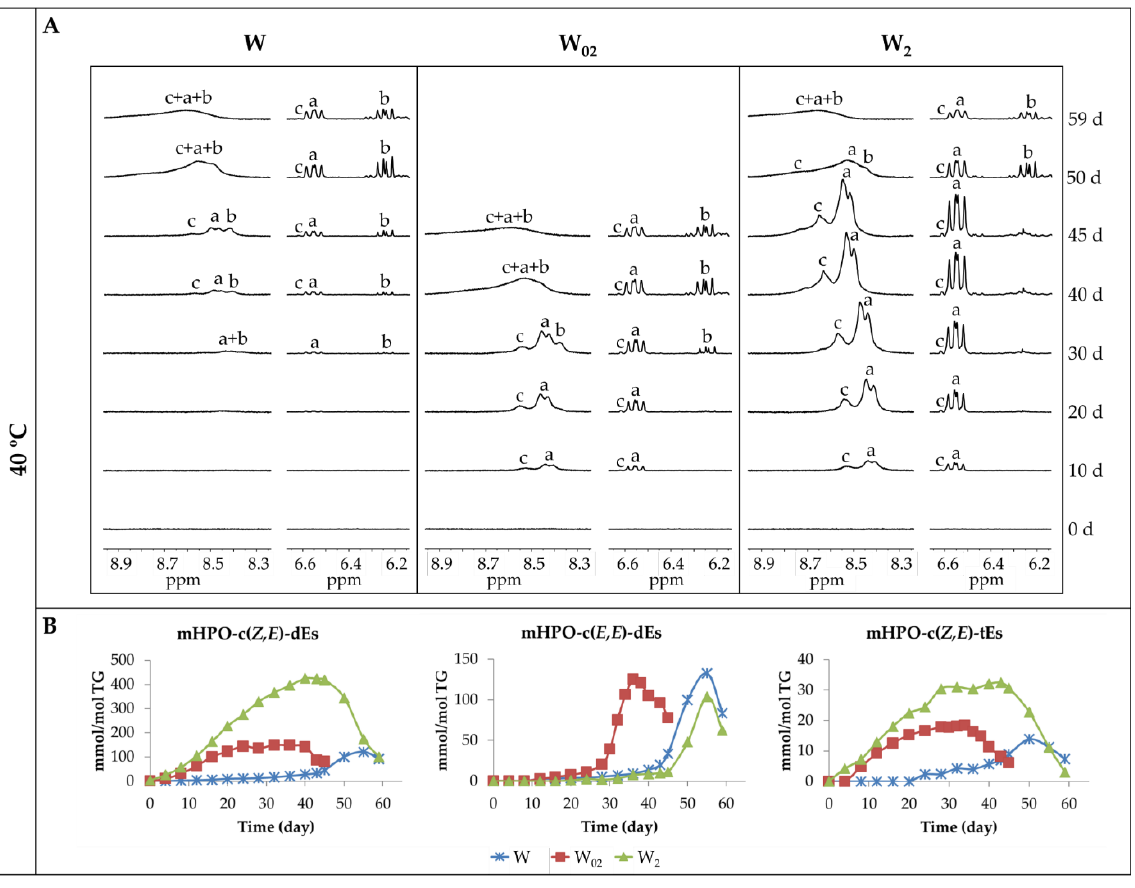
Figure 3. ( A ) 1 H NMR regions of the spectra of walnut oil samples with different αT enrichment degrees (W, W 02 and W 2 ), at different days (d) of their accelerated storage at 40 °C, in which signals of hydroperoxy protons in chains supporting conjugated dienic systems derived from linoleic and linolenic appear. Signals a and b are due to protons of mHPO-c( Z , E )-dEs and mHPO-c( E , E )-dEs respectively, derived from linoleic acyl group. Signals c are due to protons of mHPO-c( Z , E )-tEs derived from linolenic acyl group. ( B ) Evolution of the concentration of each kind of hydroperoxides throughout the storage up to advanced stages of the oxidation process.